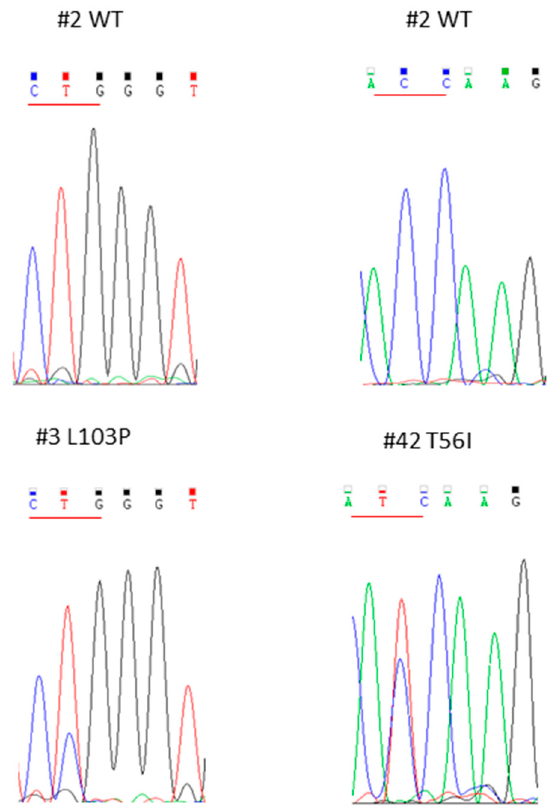
Figure 4. Representative electropherograms of IDH1 WT ( A ), R132G ( B ) and R132L ( C ) mutated samples.